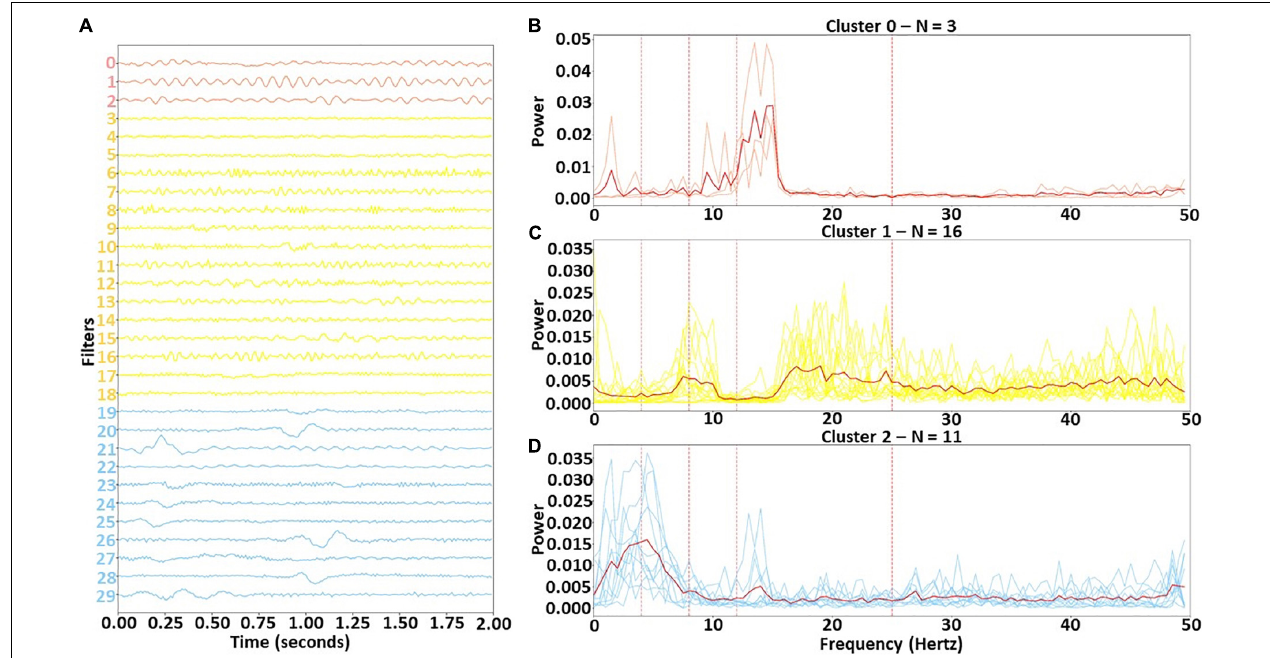
FIGURE 3 | Identified clusters in time and frequency domain. Panel (A) shows the time domain of the identified clusters, while panels (B–D) show the frequency domain of the filters in Clusters 0, 1, and 2, respectively. In panel (A) , the filters are arranged vertically based on cluster. The solid red lines in panels (B) through (D) are the cluster centers, and the vertical dashed lines show boundaries of each frequency band. Light red, yellow, and light blue lines represent Clusters 0, 1, and 2, respectively.